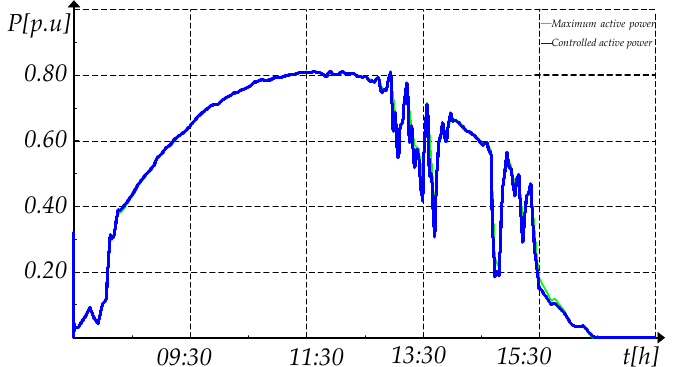
Figure 22. Active power response for day 3 considering MPPT.